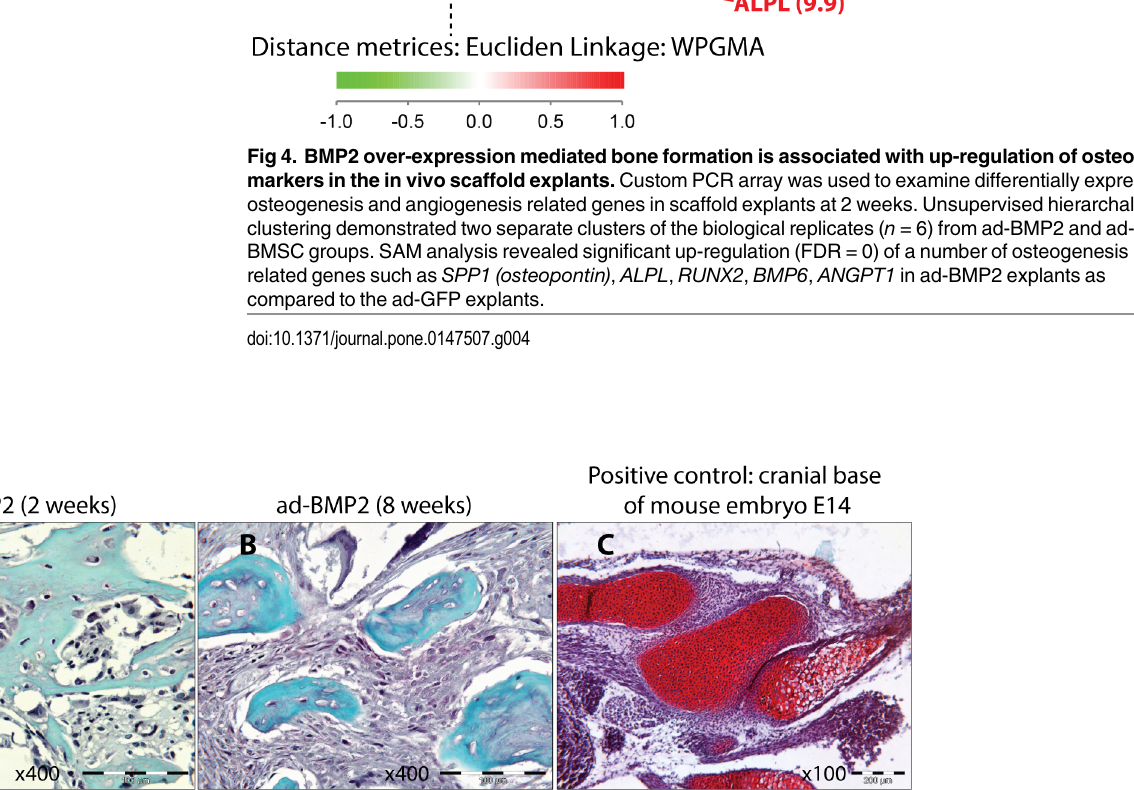
Fig 5. BMP2 over-expression mediated bone formation is not associated with enhanced chondrogenic activity. Formalin fixed paraffin embedded sections of ad-BMP2 explants at 2- and 8- weeks were stained with safranin O and counterstained with fast green. Bony structures in the scaffold explants (A and B) were negative for safranin O staining whereas the positive control (C, cranial base of mouse embryo E14) was intensely